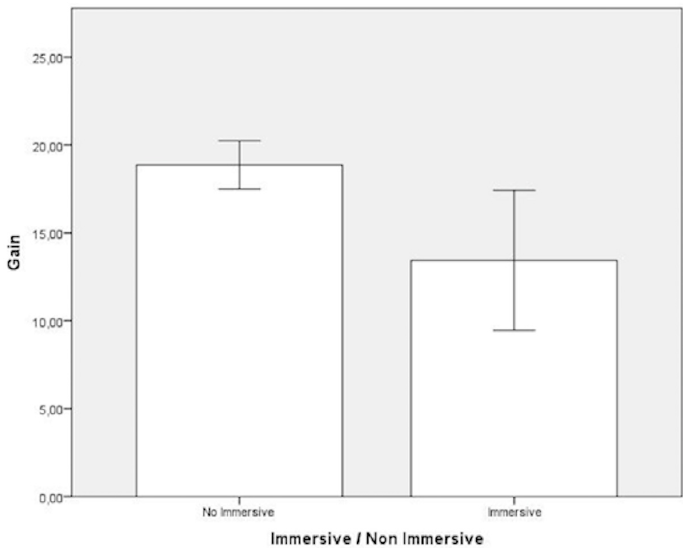
Figure 5. Mean gains as a function of immersion with a 95% confidence interval.